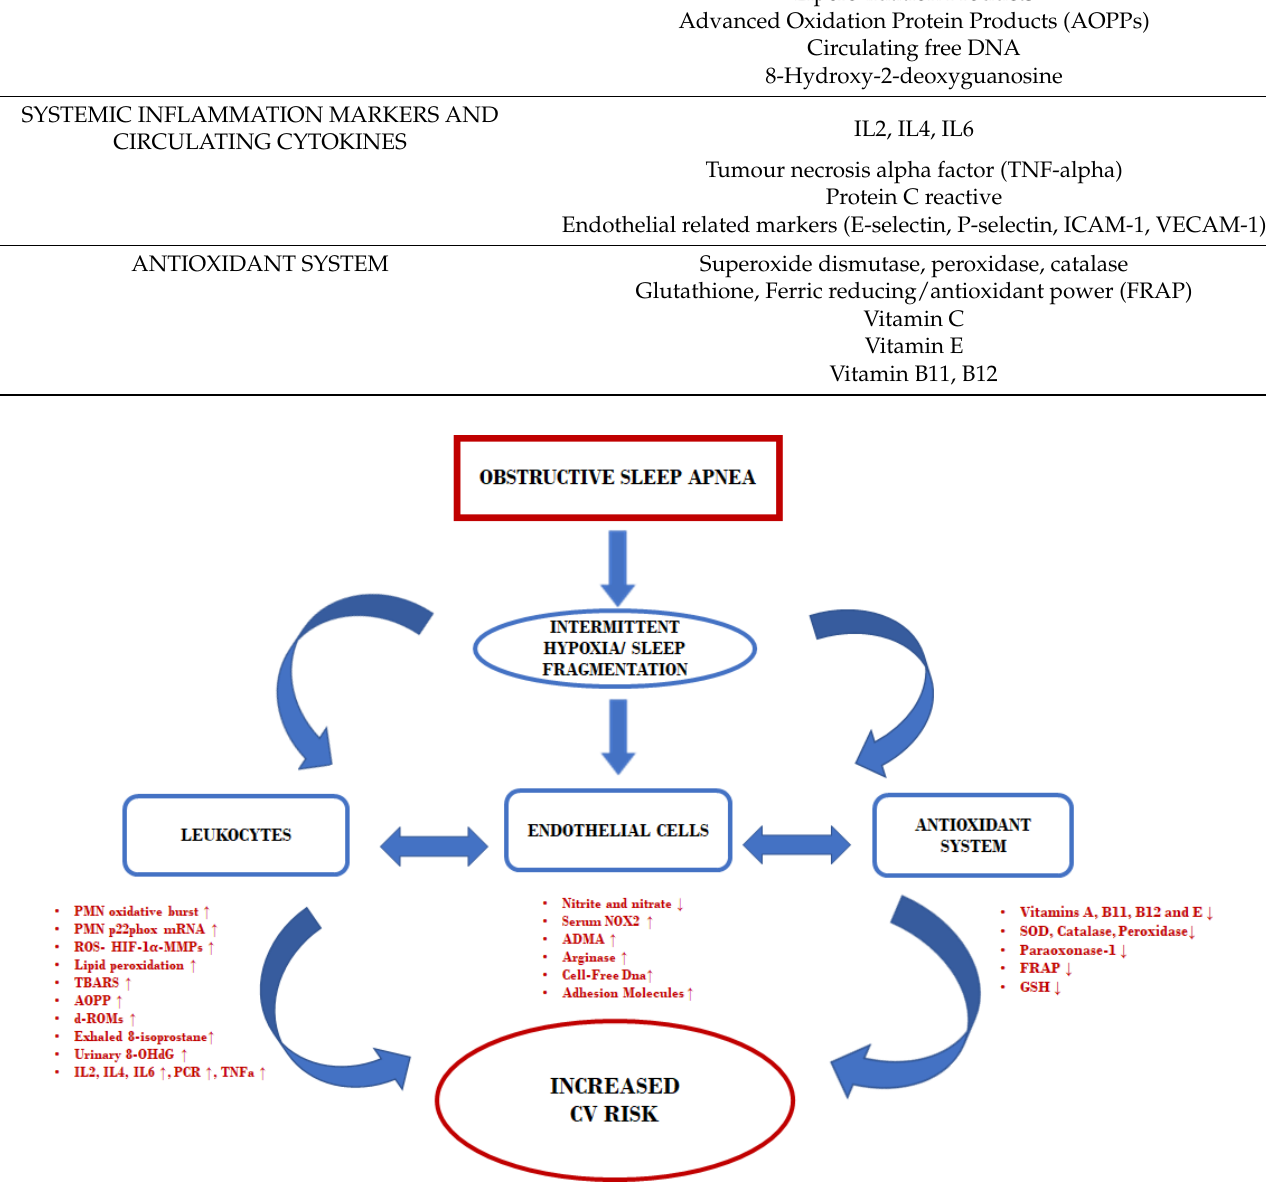
Figure 1. Flow chart OSAS flogosis pathway. Abbreviations: PMN oxidative burst, polymorphonuclear neutrophils; TBRSA, thiobarbituric acid reactive substances; Urinary 8-OHdG, urinary excretion of 8-hydroxy-2’-deoxyguanosine; ADMA, Asymmetric dimethylarginine; FRAP, ferric reducing antioxidant power; SOD, Superoxide dismutase; d-ROMs, reactive oxygen metabolites GSH, Glutathione; AOPP, Advanced Oxidation Protein Products; ROS, Reactive oxygen species; CV, Cardiovascular; HIF, Hypoxia-inducible factor; MMP, Matrix